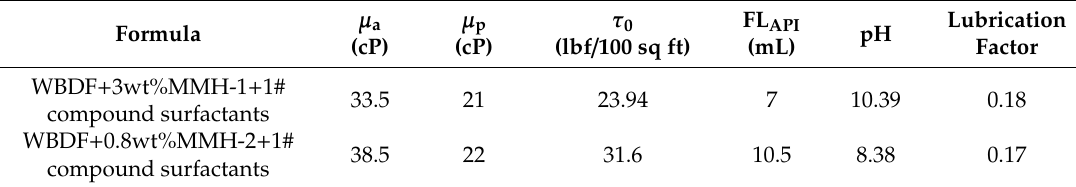
Table 8. Basic properties of the proposed drilling fluid formula.